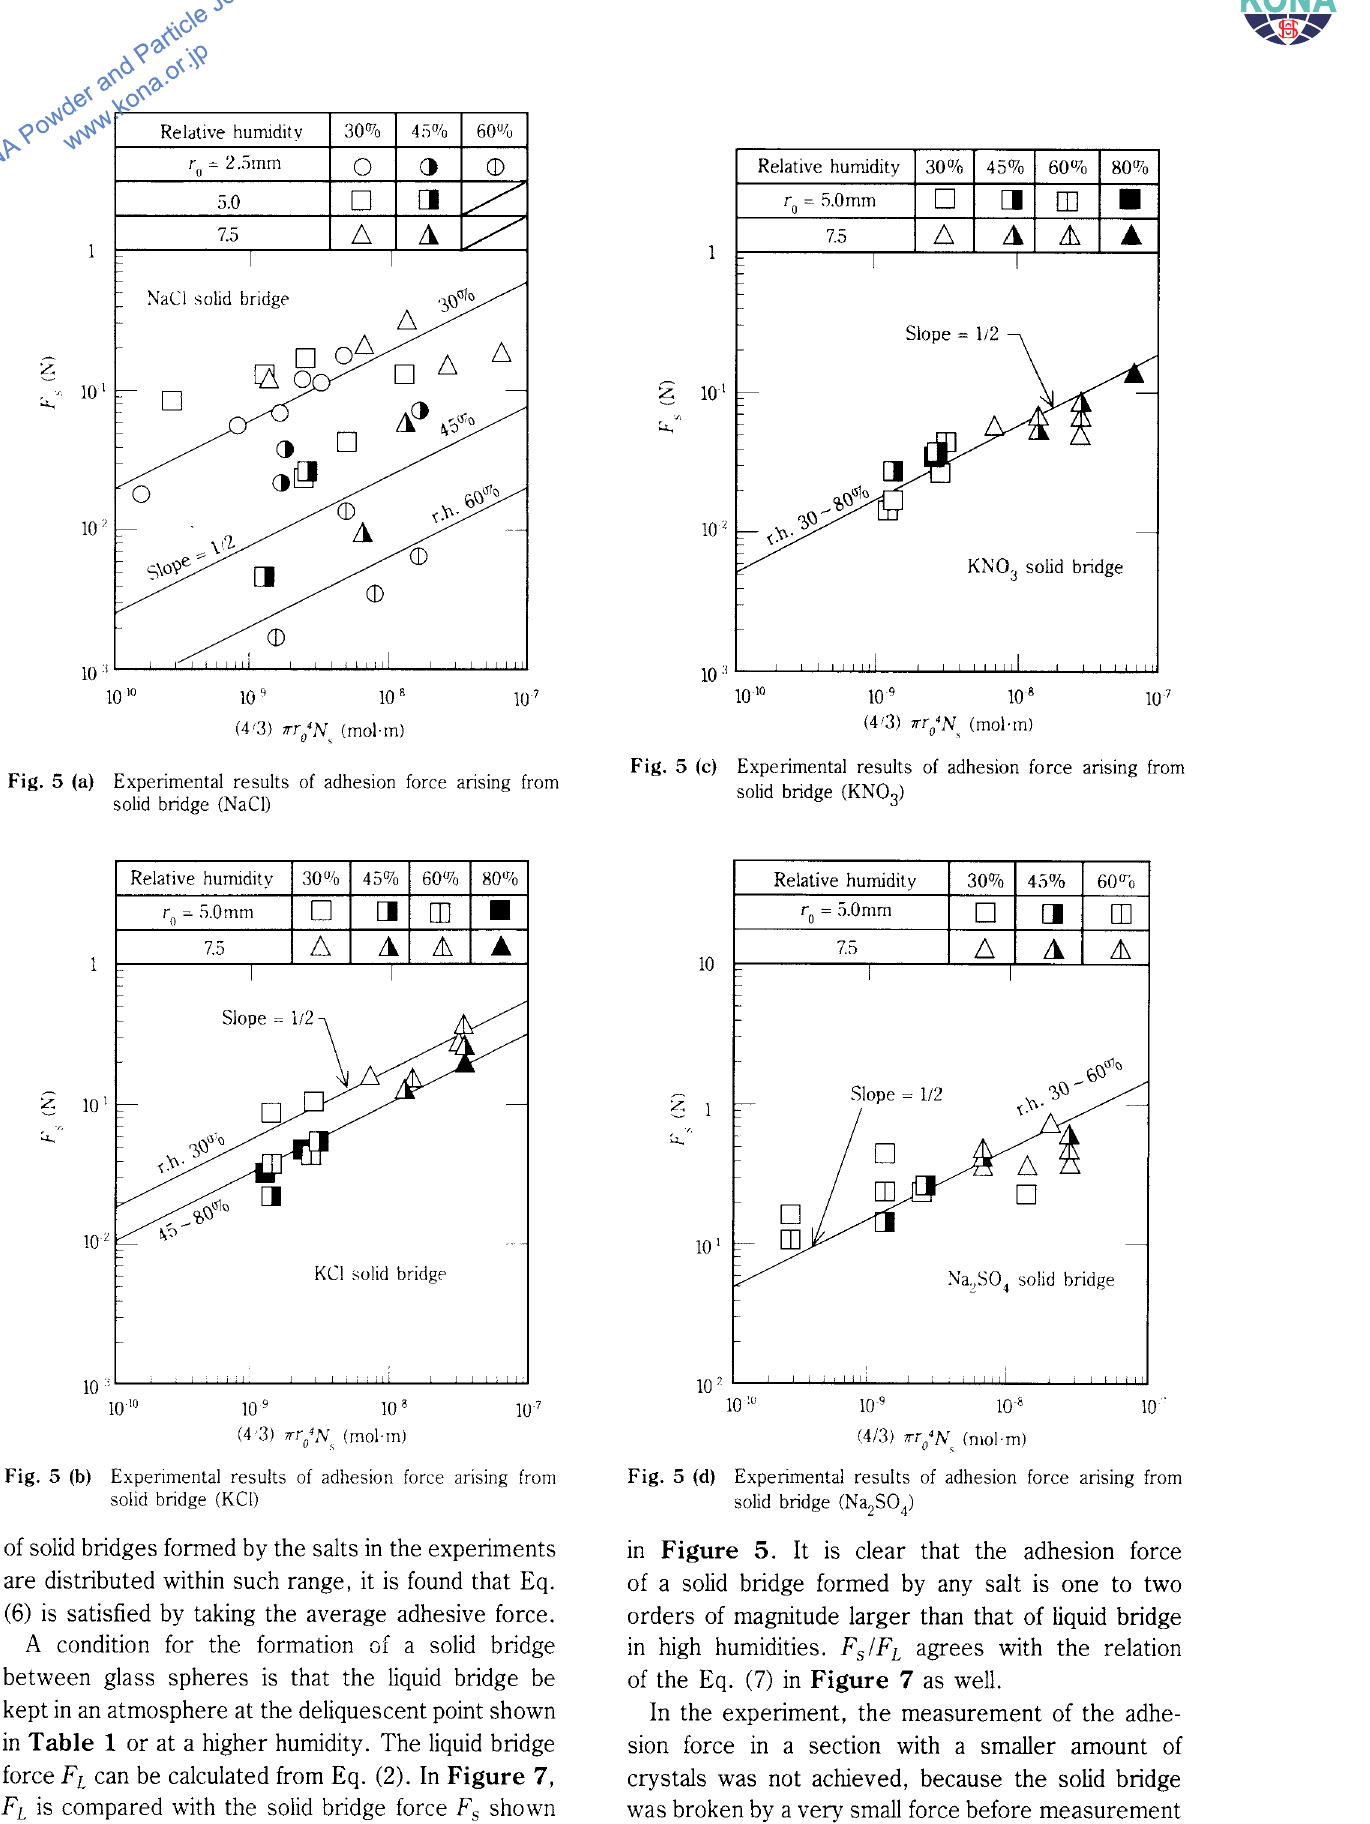
Fig. 5 (d) Experimental results of adhesion force arising from solid bridge (Na SO 2